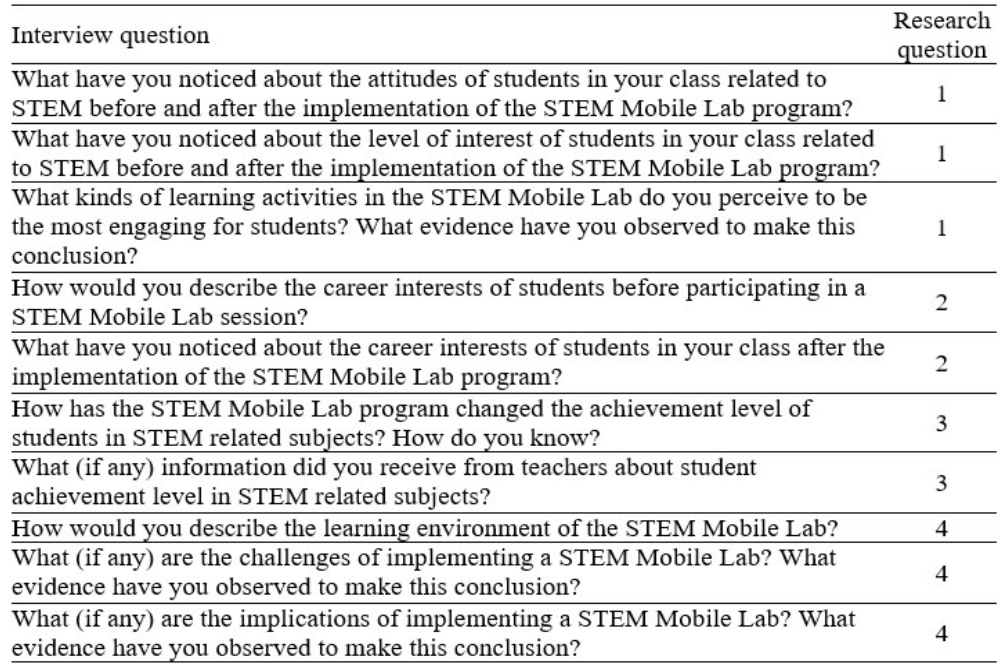
Table 2. Instructional designer struc-tured interview questions and the alignment to the research questions of the